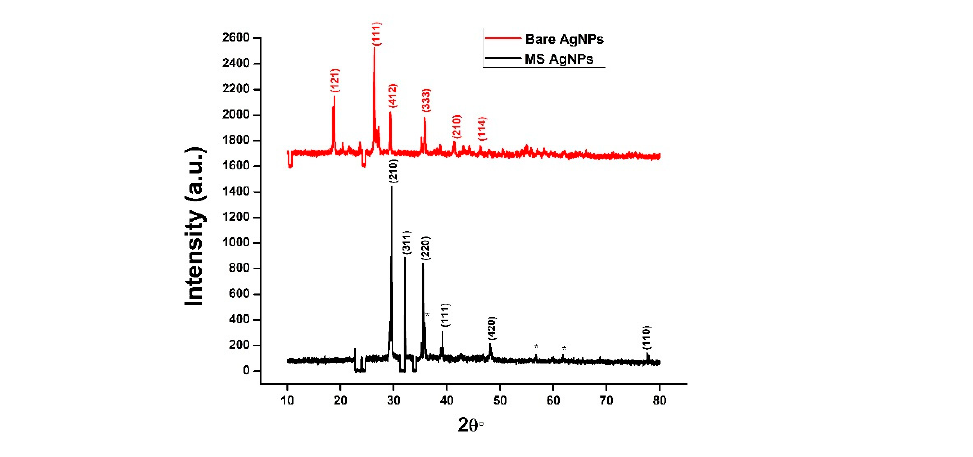
Figure 2. XRD pattern of the MS-AgNPs (black spectra) and bare AgNPs (red spectra). The * represent unkonown peaks in the black spectrum.